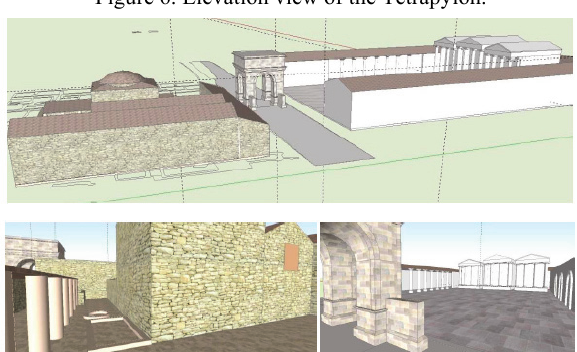
Figure 6. Elevation view of the Tetrapylon.